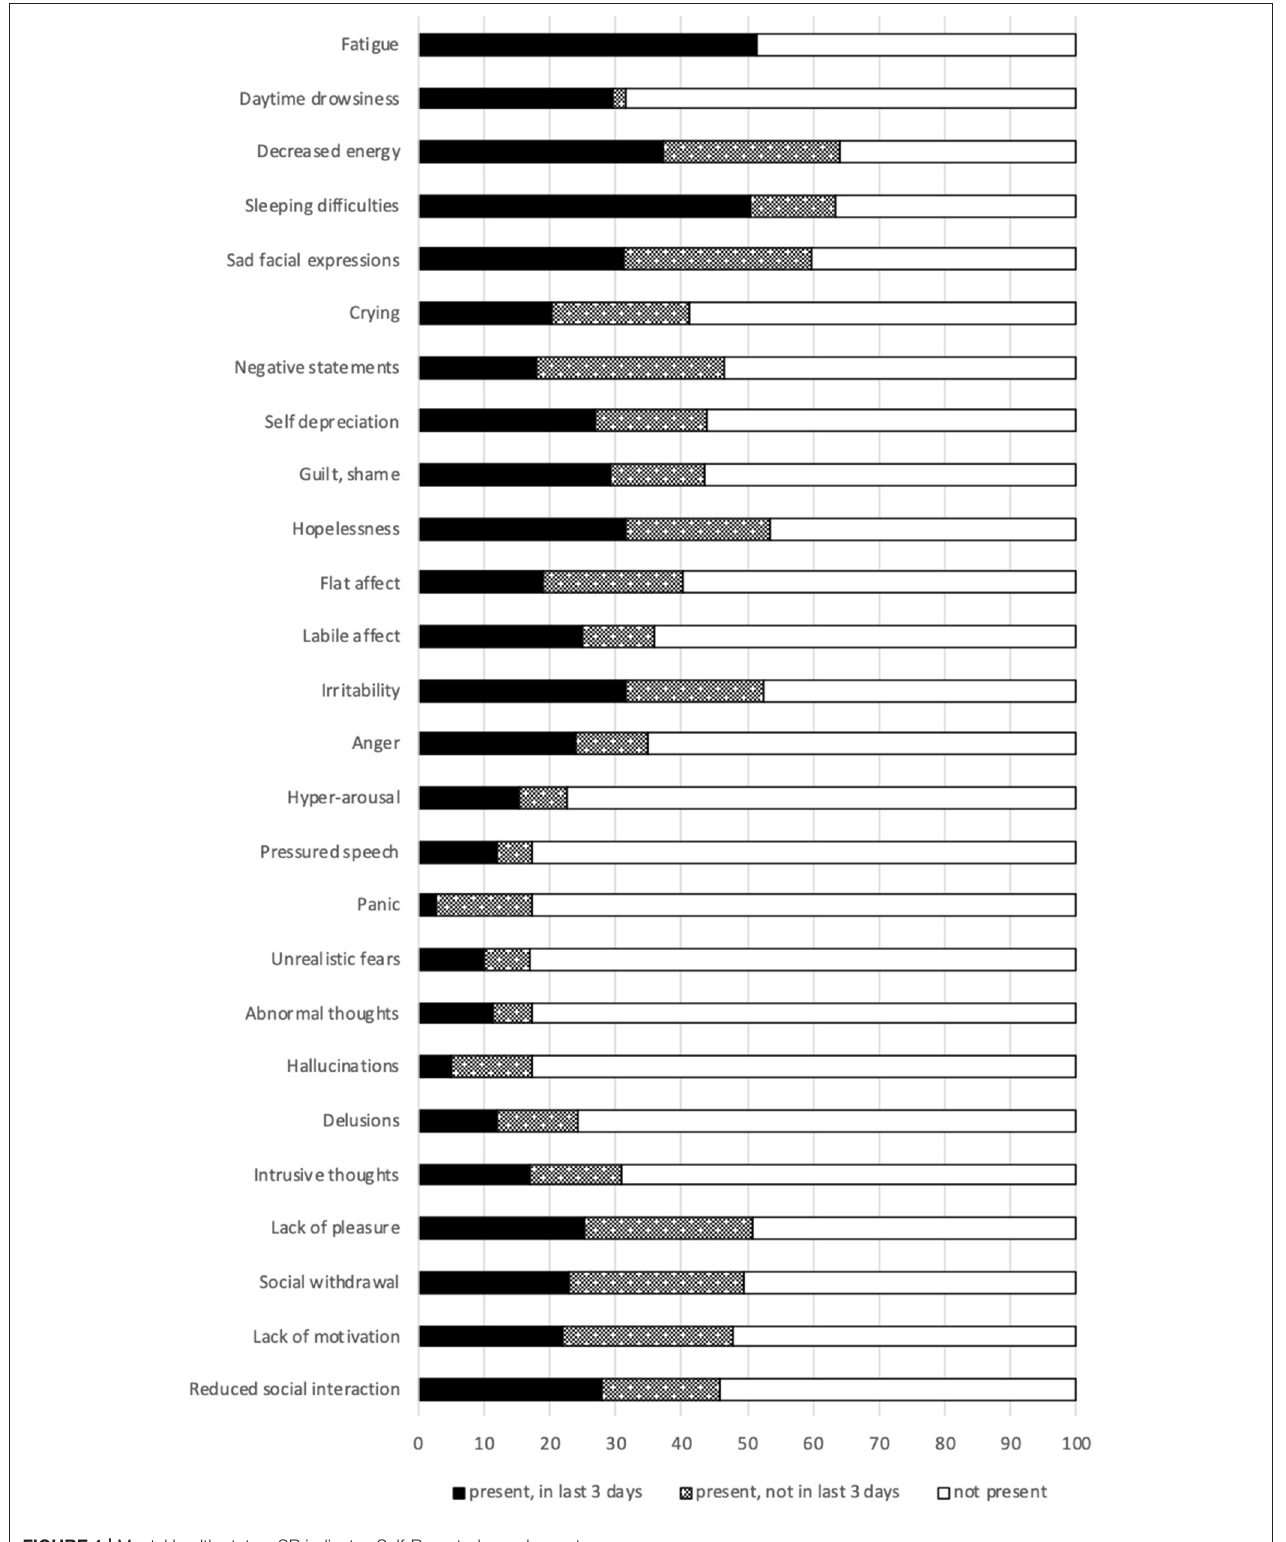
FIGURE 1 | Mental health status. SR indicates Self-Reported mood symptoms.